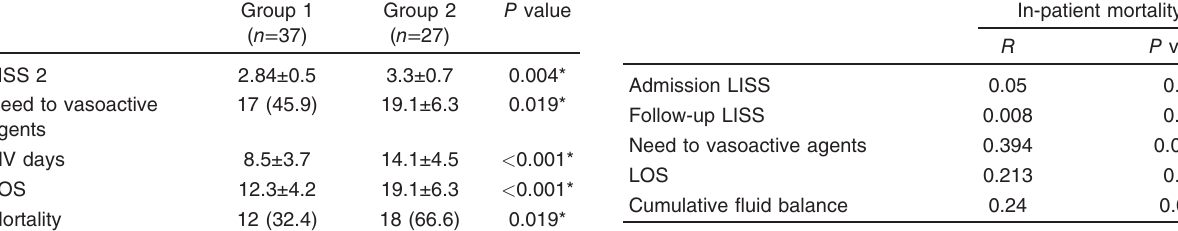
In-patient mortality